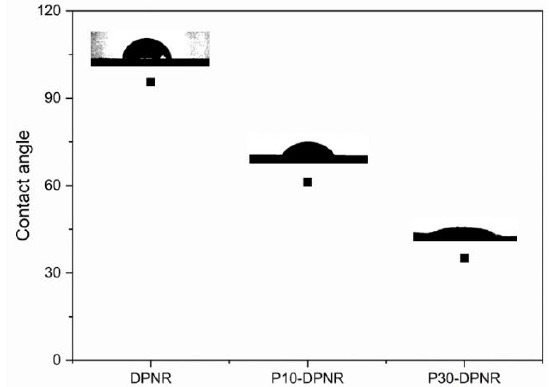
Figure 7. Contact angle of DPNR, P10-DPNR, and P30-DPNR.